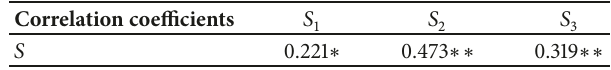
Table 3: Analysis results of the subjective evaluations and objective metrics.